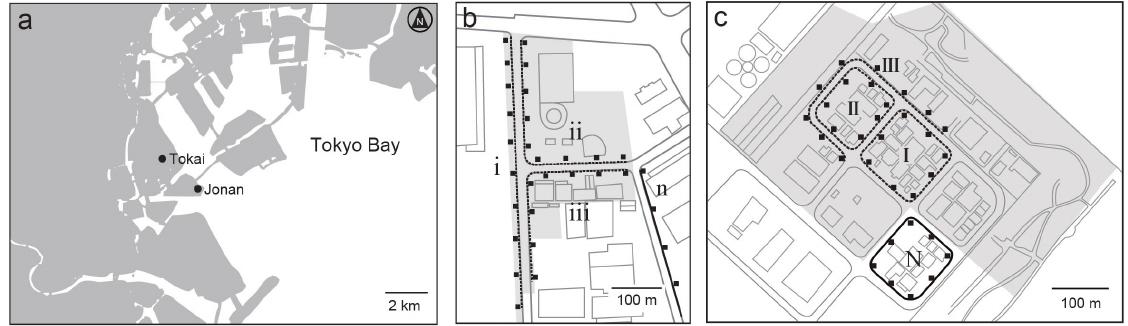
Fig 1. Maps of (a) Tokyo Bay area and monitoring plots at (b) Tokai and (c) Jonan. Solid line indicates transects in non-invaded plots (n, N); dashed line indicates transects in plots invaded by Linepithema humile (i–iii, I–III). Squares indicate locations of sticky